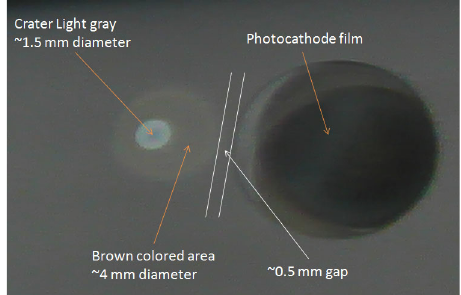
5. A close-up photo of the photocathode film and sub- strate after use.